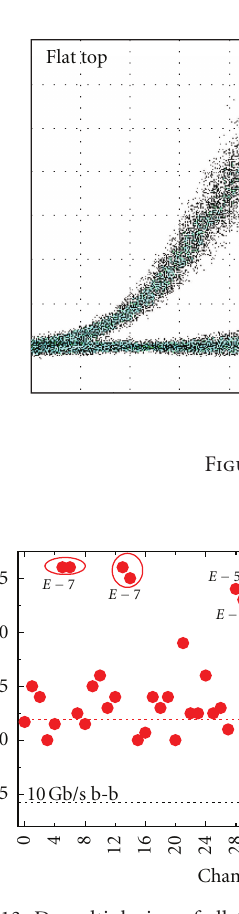
Figure 13: Demultiplexing of all 64 tributary channels using flat- top gating pulses.